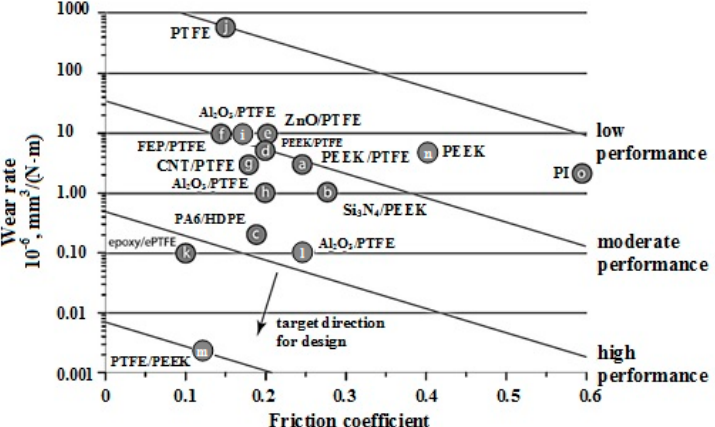
Figure 1. Wear rate plotted versus friction coefficient for various solid lubricating polymeric composites, unfilled polymers, and polymer blends. The target region is the lower left hand corner, a region of ultra low wear rate and friction coefficient. The data points are labeled with the constituents and listed as: (a) PTFE/PEEK (polyether-ether-ketone) composite [45]; (b) Si 3 N 4 /PEEK nanocomposite [46];